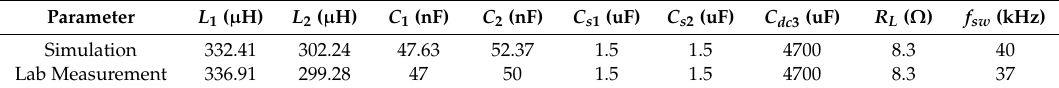
Figure 21. Laboratory setup of a 3.7 kW WPT system. Table 4. Parameters of the laboratory testing.